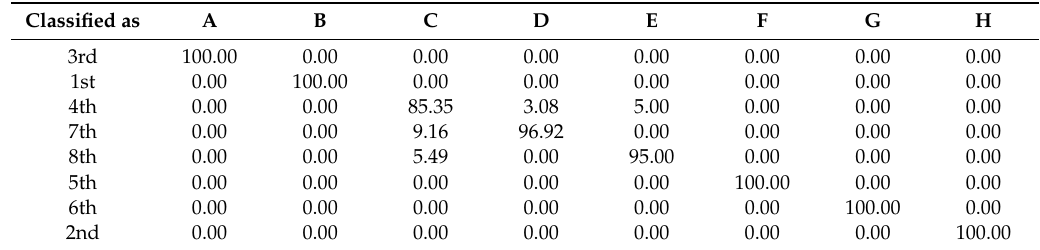
Table 5. Confusion Matrix on cluster